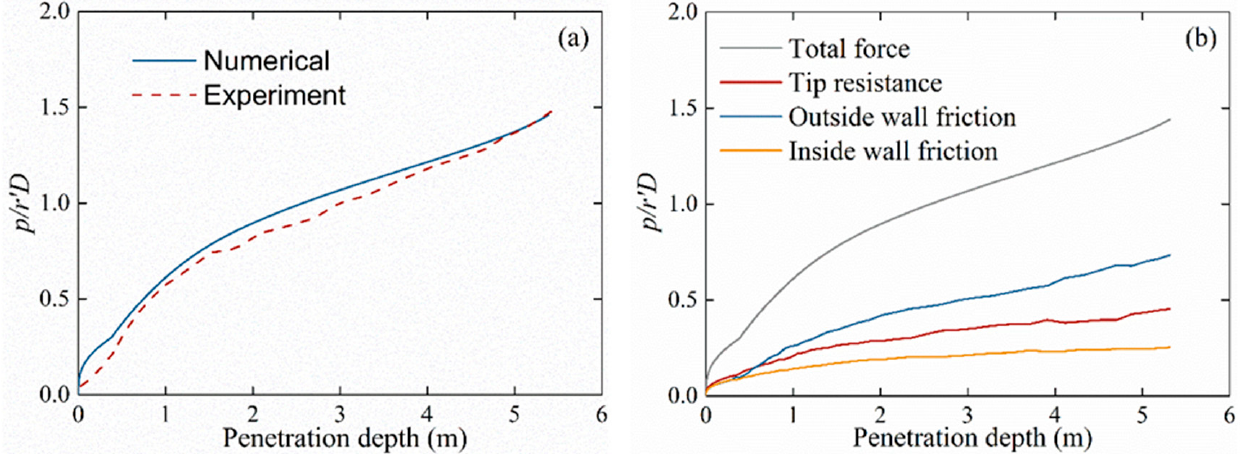
Figure 8. Suction penetration resistance: ( a ) Numerical and centrifuge test results for penetration resistance; ( b ) Decomposition of penetration resistance from numerical results.